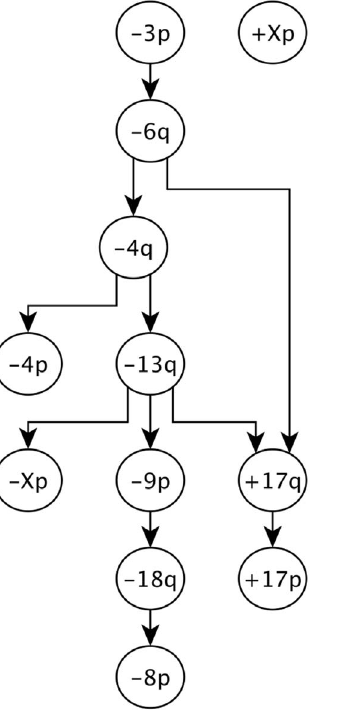
Figure 5. The learned MPN for RCC data with k ~ 3 and e ~ 0 : 2 . The smaller dataset in [10] is used. + sign stands for gain and 2 sign stands for loss in a chromosome arm. Long and short arms of each chromosome are denoted by q and p ,